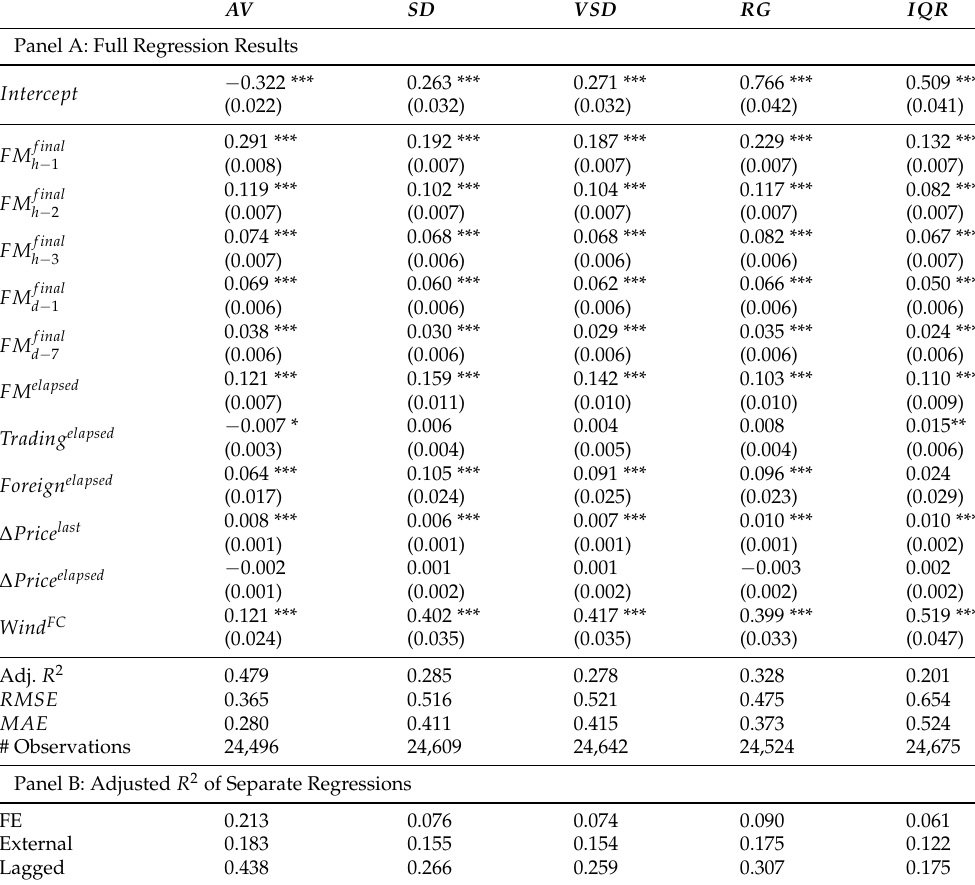
Table 8. Results of the forecast regressions for the five measures AV (the standard deviation of the price differences consecutive trades), SD (the standard deviation of all trades for a contract), VSD (the volume-weighted standard deviation of all trades for a contract), RG (the range of all trades for a contract), and IQR (the interquartile range of all trades for a contract). Panel A shows the results of the full regression, and Panel B shows the adjusted R 2 of separate regressions, using exclusively the fixed effects, the external variables, and the lagged variables, respectively. FM final , FM final , FM final , h − 1 h − 2 h − 3 FM final , FM final are lagged fluctuations measures for the contracts expired in the previous hours, d − 1 d − 7 and FM elapsed is the realized fluctuation measure of the specific contract during the elapsed time of trading. Trading elapsed is the traded volume during the elapsed time of trading, Foreign elapsed is the relative share of the total volume traded between Germany and a foreign country during the elapsed time of trading, ∆ Price last is the absolute (unsigned) difference between the last intraday price obtained immediately before the start of the last hour and the day-ahead price, ∆ Price elapsed is the absolute (unsigned) difference between the volume-weighted average intraday price obtained during the elapsed time of trading and the day-ahead price, and Wind FC is the relative forecasted wind energy share of the forecasted total consumption. RMSE is the root mean squared error, and MAE is the mean absolute error. The asterisks denote the significance level with *** = 0.1% and * = 5.0%. AV